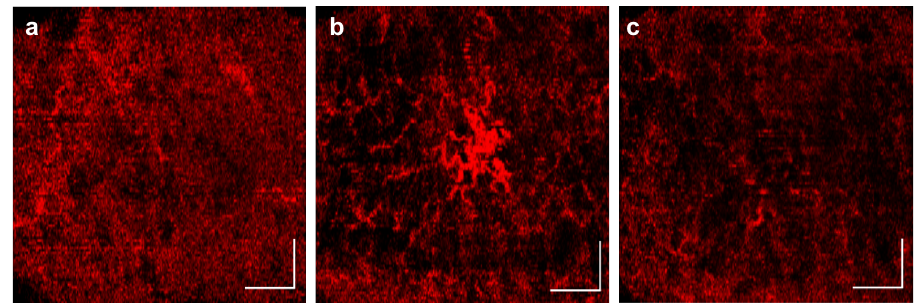
Figure 6. Vascular images directly from the VivoSight showing the same lesion ( a ) upon arrival, ( b ) after heating, ( c ) after cooling. The axis in each image represents a 1 mm × 1 mm